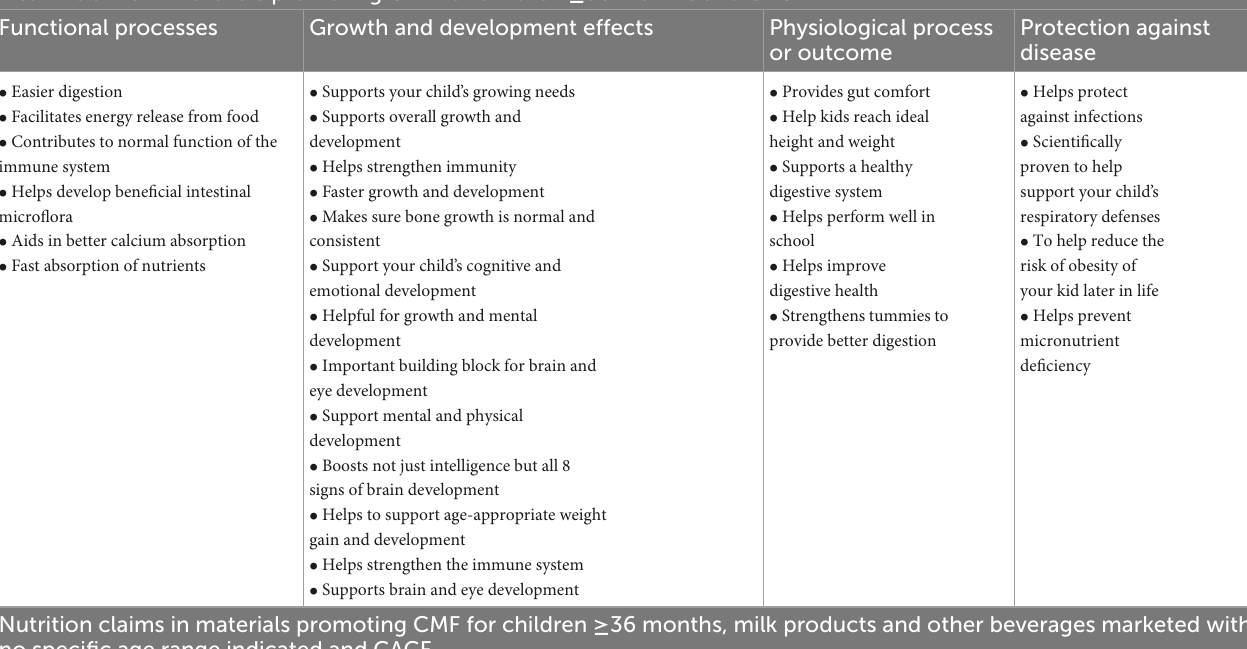
TABLE 5 Examples of product benefit claims in unique promotional materials. Health claims in materials promoting CMF for children ≥ 36 months and